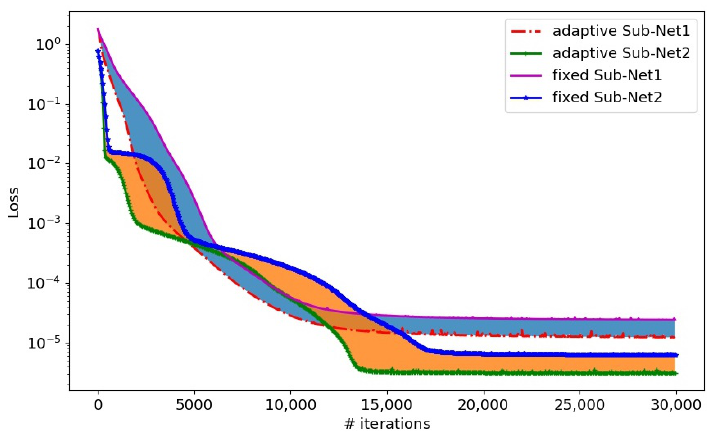
Figure 13. The plot of L s average error loss for Example